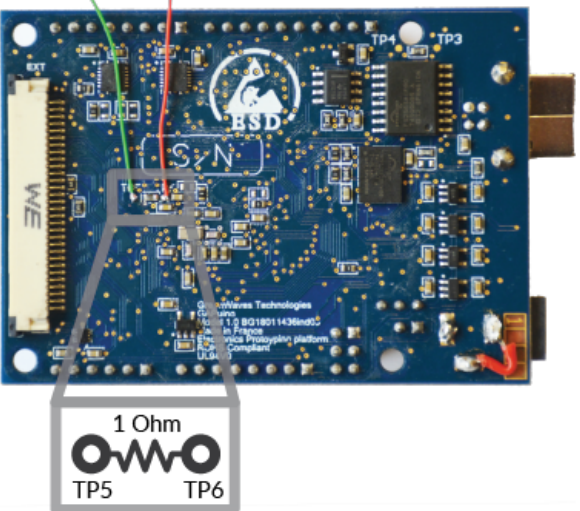
Figure A1. Measurement setup for power consumption showing a R = 1 Ω shunt resistor at the bottom of the of the GAPuino evaluation [23] board with two measurement points (TP5 and